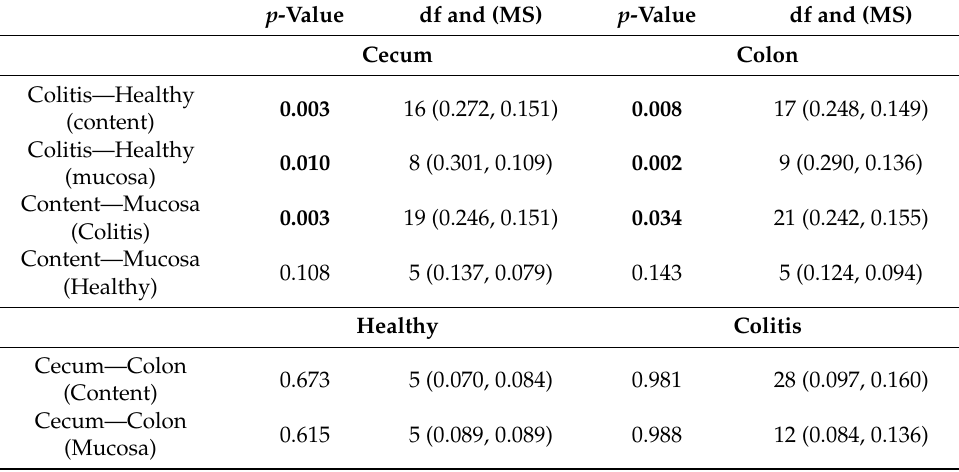
Table 2. p values, degrees of freedom (df) and mean of the sum of squares (SM) obtained from the analysis of molecular variance (AMOVA) test, comparing bacterial composition present in the intestinal content and mucosa of the cecum and colon of horses with diarrhea and healthy